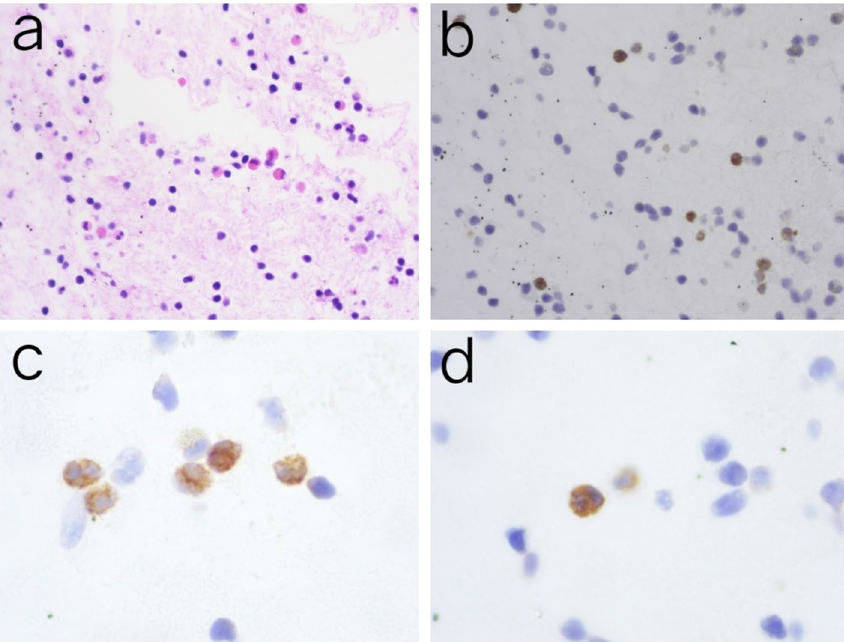
Figure 3. Lung tissue stained with H&E and immunohistochemistry. ( a ) lung tissue stained with H&E, Alveolar was infiltrated with eosinophils (× 400 magnification). ( b ) There are CEA positive cells in lung tissue (× 400 magnification). ( c and d ) Immunostaining for CEA showed that CEA was observed in the cells which were characteristic of eosinophils (× 800 magnification).